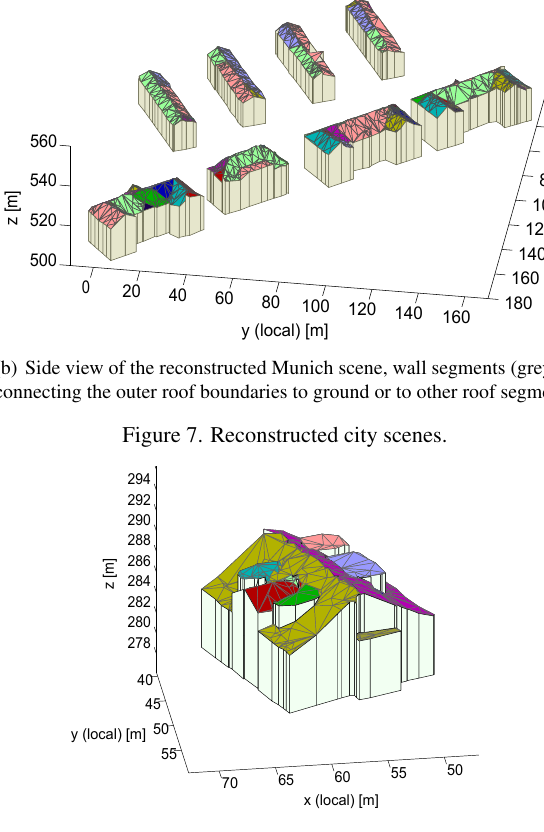
Figure 8. Detailed building model in a local coordinate